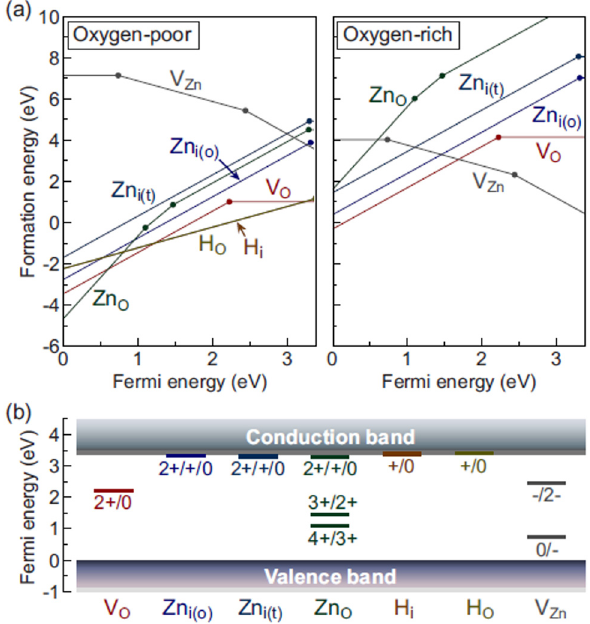
Figure 14: ( a ) Defect formation energies as a function of the Fermi energy at the oxygen - poor and oxygen - rich limits, which were obtained using the Heyd - Scuseria - Ernzerhof ( HSE ) ( a = 0.375 ) hybrid functional with the fi nite - size corrections. The slope corre - sponds to the charge state. ( b ) Defect transition levels equivalent to Figure 13: The geometrical representation of the di ff erent defects: ( a ) Zn ( b ) oxygen interstitial ( O ) , ( c ) V ( d ) oxygen vacancy. the fi lled circles in ( a ) , alongside the relevant charge states. i , i Zn , and Reproduced with permission from American Physical Society [ 59 ] Reproduced with permission from Elsevier [ 60 ] .